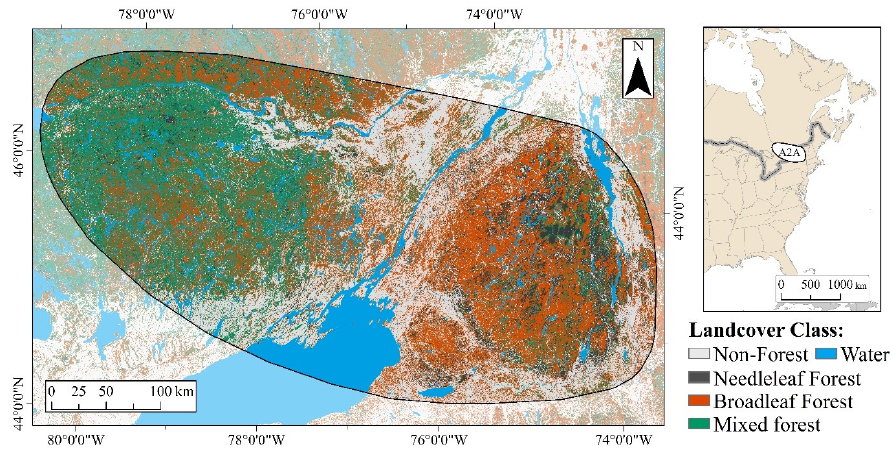
Figure 1. Map of the location and forest cover of A2A, with landcover classes from [34]. The land area of A2A is >135,000 km 2 , of which 61% is forests (calculated using [34]). Most forests are deciduous (32% of total area), dominated by maples ( Acer rubrum and Acer saccharum ), red oak ( Quercus rubra ), and American Beech ( Fagus grandifolia ) [35,36]. Conifer- ous forests represent a smaller proportion (9% of total area), mainly in high elevation